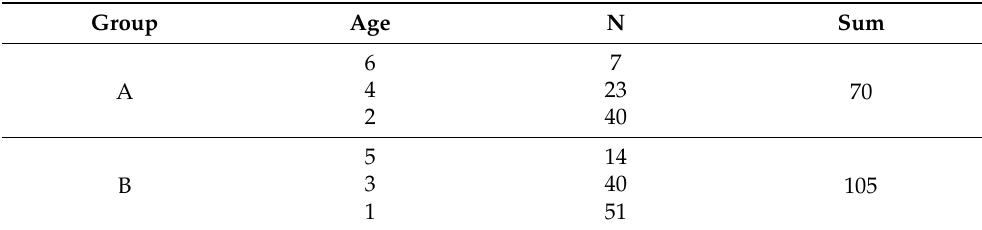
Table 2. Age and number of 175 red wine samples used for distinguishing